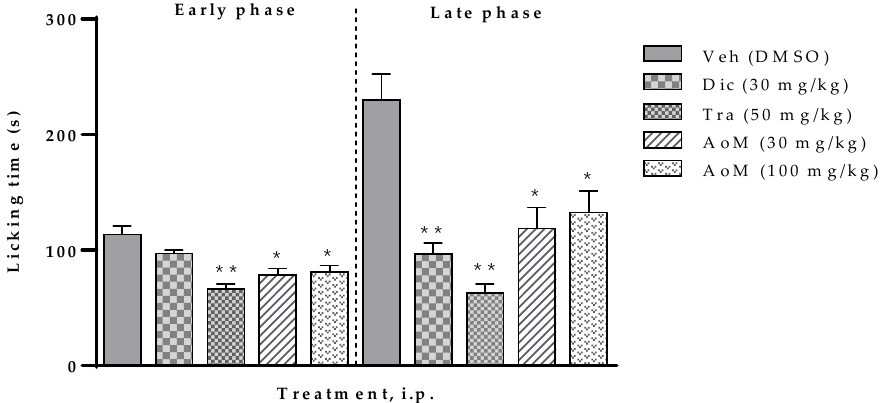
Figure 2. E ff ect of the methanolic extract of Aristolochia odoratissima (AoM, 30 and 100 mg / kg, i.p.) in the formalin test (2.5%, 25 µ L / paw) in mice. The data are expressed with the mean ± sem. One-way ANOVA + Dunnett test, * p < 0.05 and ** p < 0.001. Veh: Vehicle; Dic: Diclofenac, Tra: Tramadol.